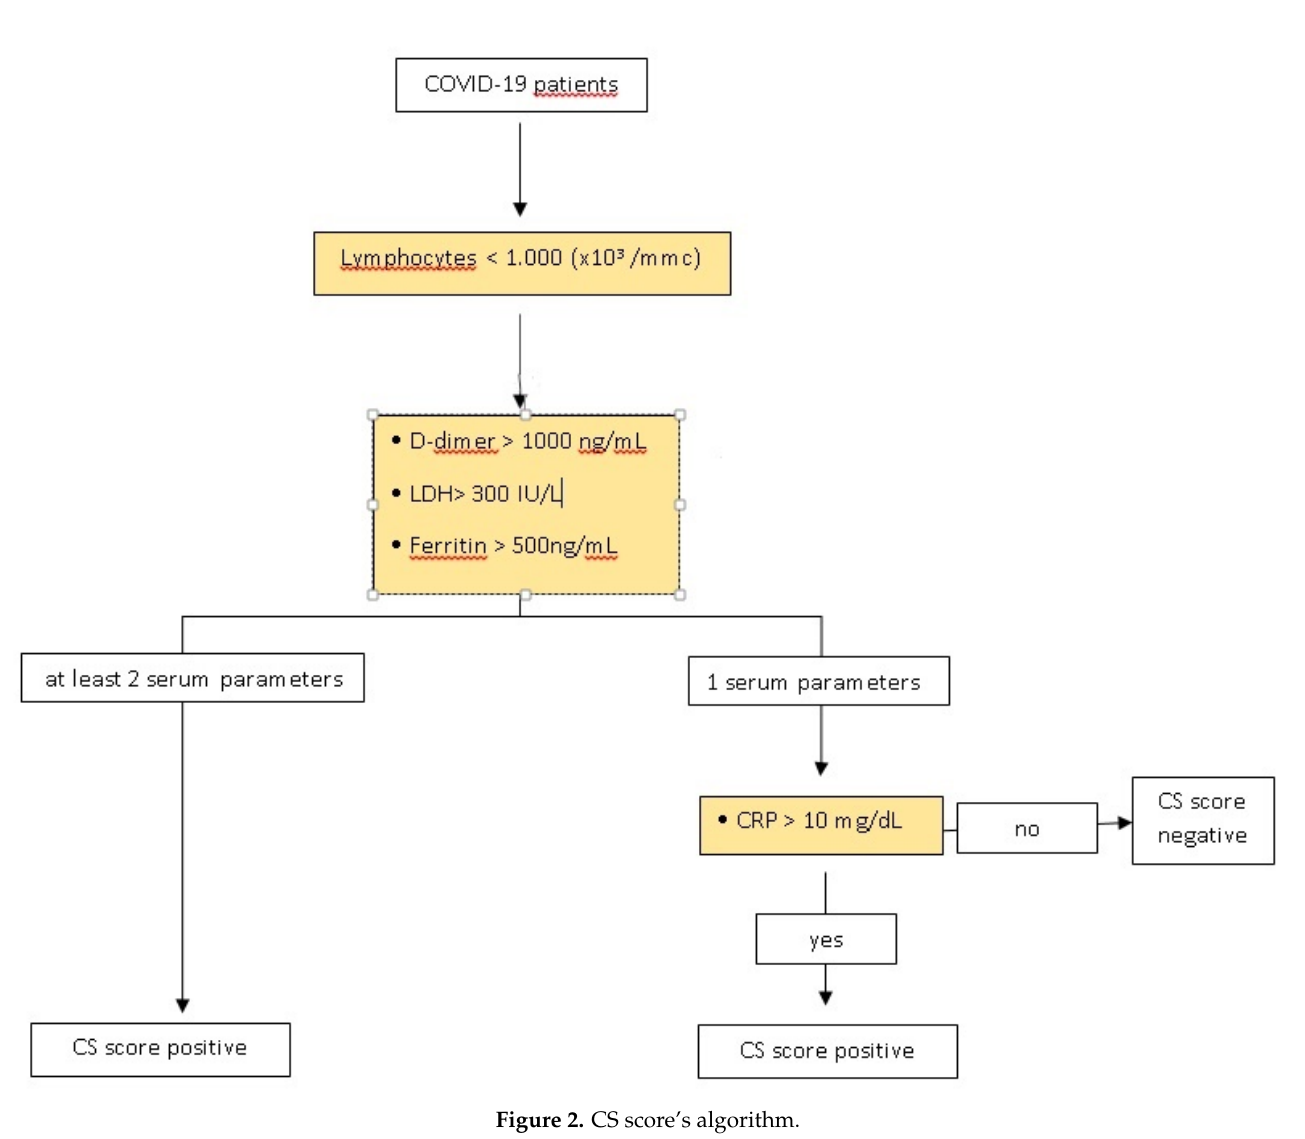
Figure 2. CS score’s algorithm.